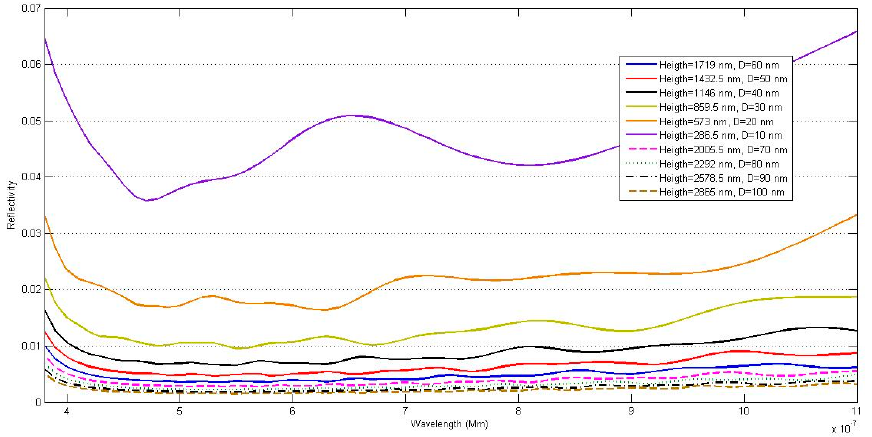
Figure 10. Spectral reflectance of the needle-like microstructures according to the height and periodicity mentioned in the legend.